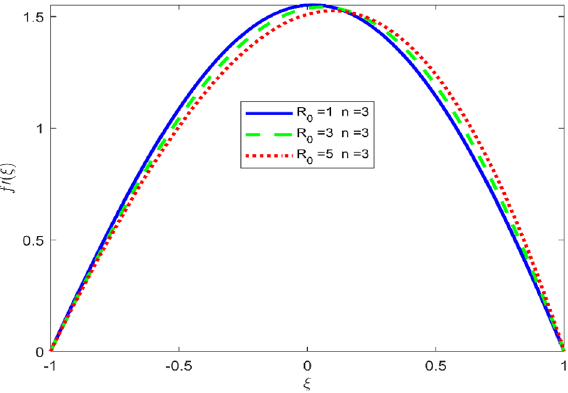
Figure 15. Effect of R 0 upon velocity profile f ′ (ξ) , for selected values of β = 0.2, m = 1, Ha = 1, φ 1 = φ 2 = φ